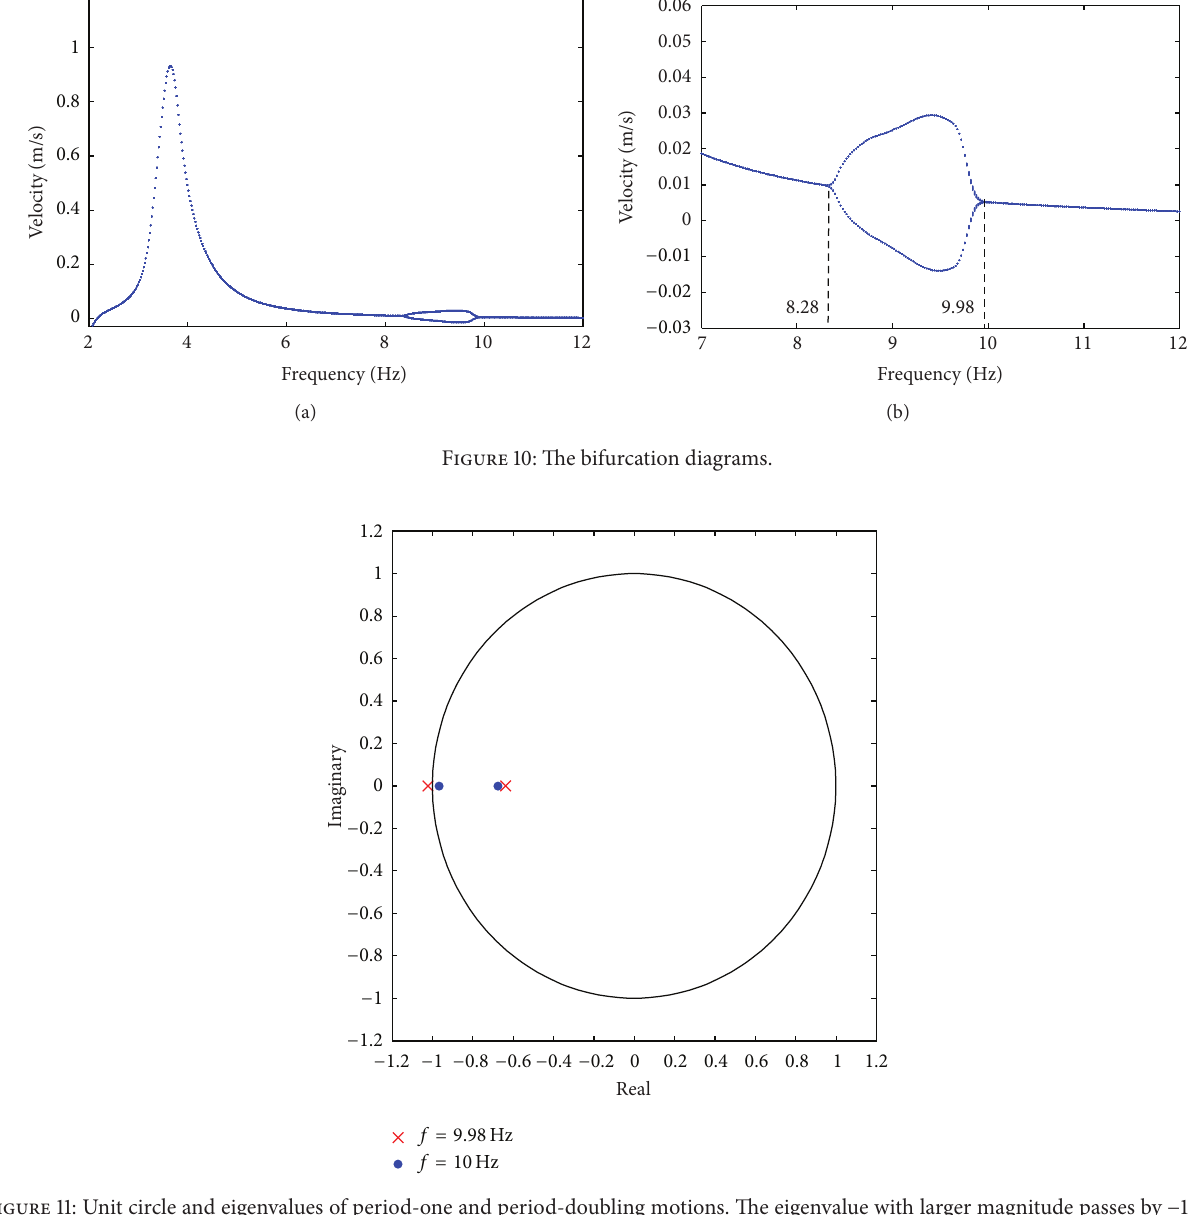
Figure 11: Unit circle and eigenvalues of period-one and period-doubling motions. The eigenvalue with larger magnitude passes by − 1 into unit circle from − 1.022 to −